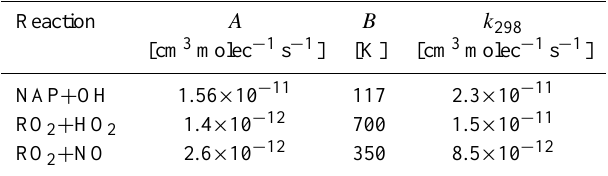
Table 4. Rate constants for IVOC oxidation. k = A e B/T .